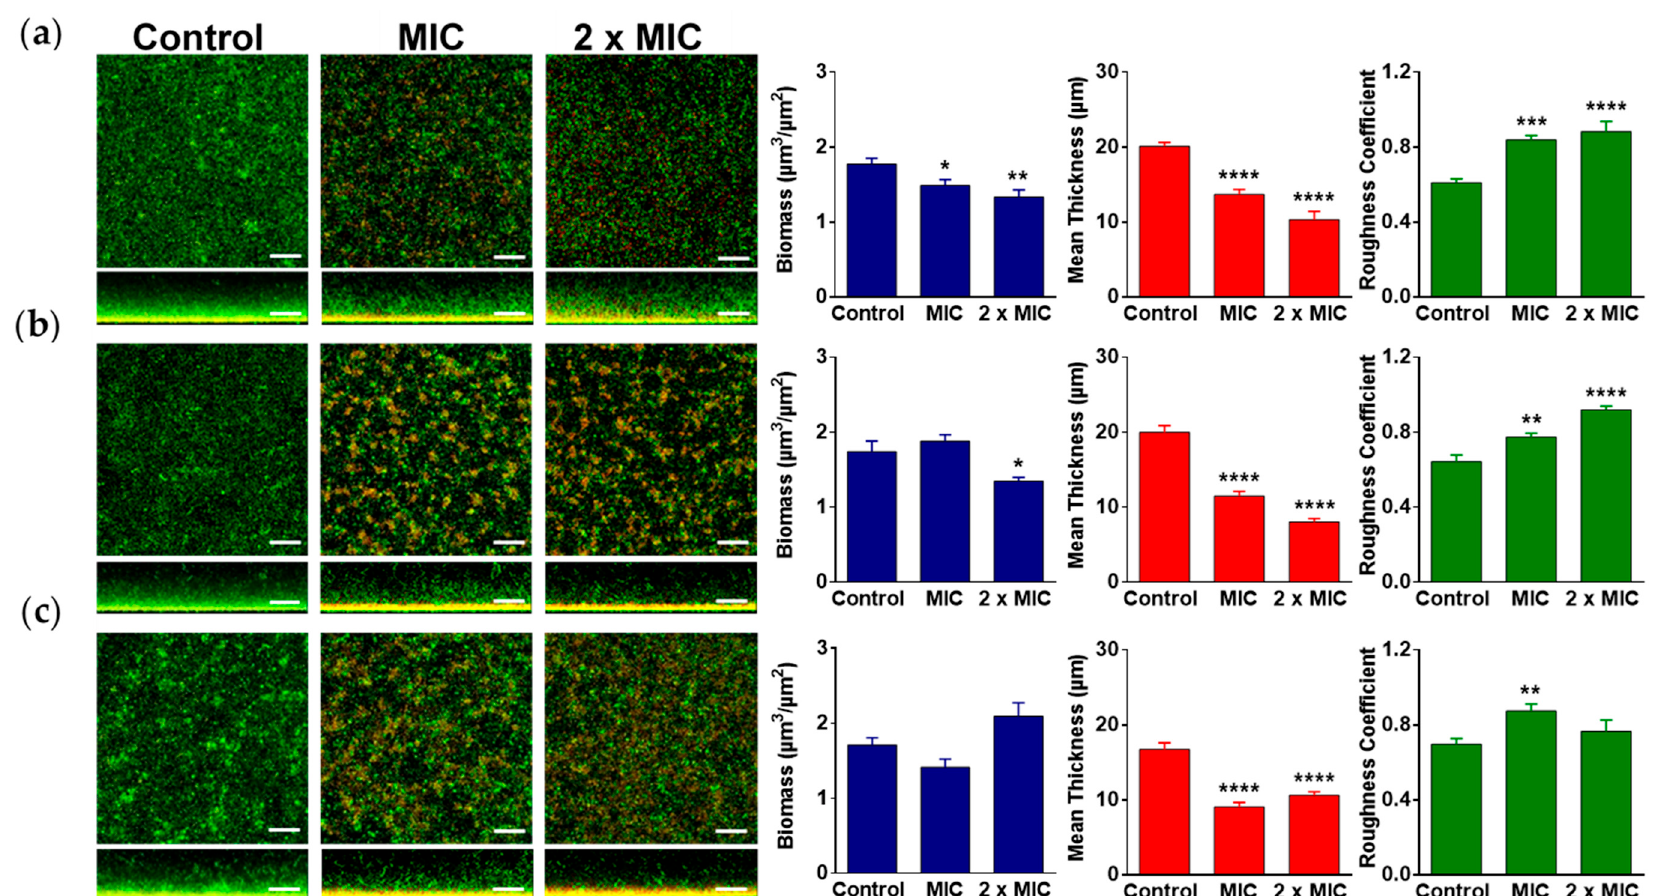
Figure 3. Biofilm formation assay showing LIVE / DEAD (green / red, respectively) stained confocal laser scanning microscopy (CLSM) images (aerial and cross-sectional views, scale bar, 35 µ m) of P. aeruginosa R22 biofilms grown for 24 h in the presence of ( a ) OligoG–A–colistin (MIC, 2 µ g / mL colistin base), ( b ) OligoG–E–colistin (MIC, 1 µ g / mL colistin base) and ( c ) colistin sulphate (MIC, 0.5 µ g / mL colistin base). Corresponding COMSTAT analysis of the CLSM images is also shown ( ± SEM; n = 15). Significance is indicated by *, where * p < 0.05, ** p < 0.01, *** p < 0.001, **** p < 0.0001 compared to an untreated control.